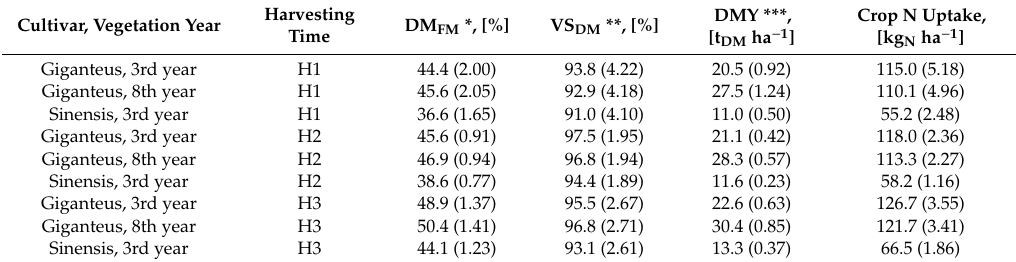
Table 5. Miscanthus: DM and VS- content at harvest time, dry matter yield per hectare and N-uptake. Units are given in square brackets. Values are given as mean; standard deviation is given in round